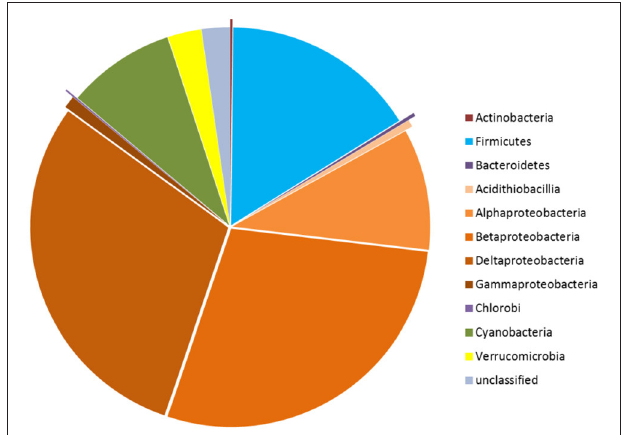
FIGURE 2 | Taxonomic distribution of the nifH gene sequences in the three geographic regions at phylum level, except for phylum Proteobacteria which is presented at class